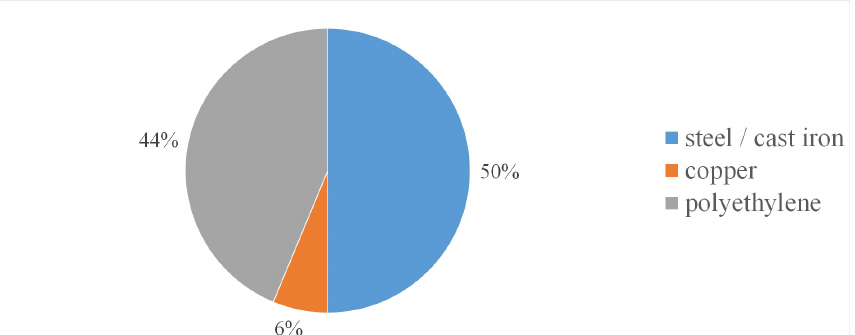
Figure 6. Category #2: pipe material. Percentage of the papers in terms of pipe material: steel/cast iron (Fe), polyethylene (PE), and copper (Cu).